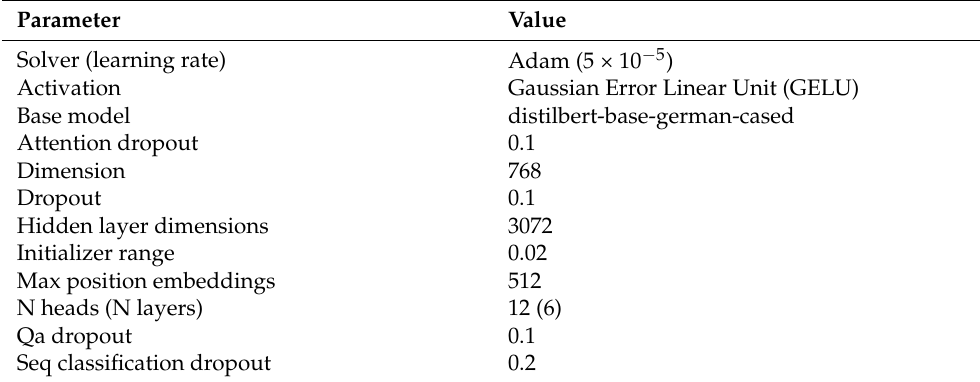
Table 2. Parameters used by the entity recognition and entity classification transformer model.